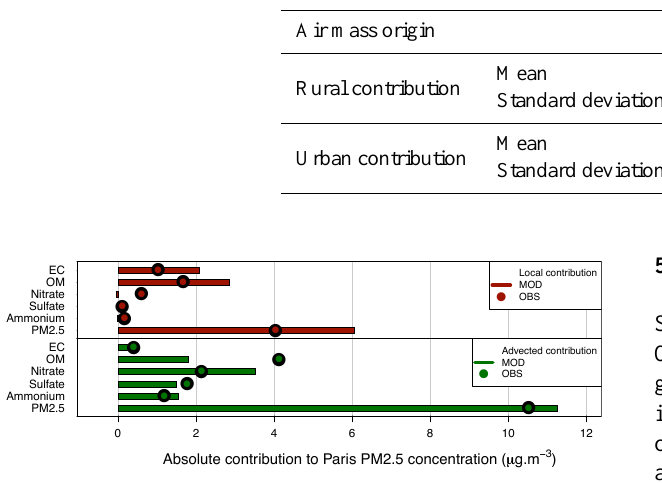
Table 5. Average and standard deviation of the advected and local observed PM 2 . 5 contribution (µgm − 3 ) , depending on the air mass origin.